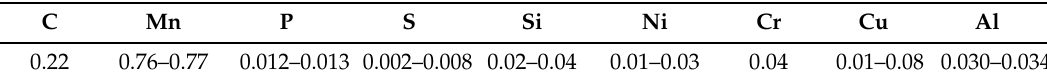
Table 1. A subcritical process is used for spheroidized annealing of the steel wire, simply heating it to below the lower critical temperature and maintaining this temperature. Table 1. Chemical composition of AISI 1022 low carbon steel wires (wt. %).